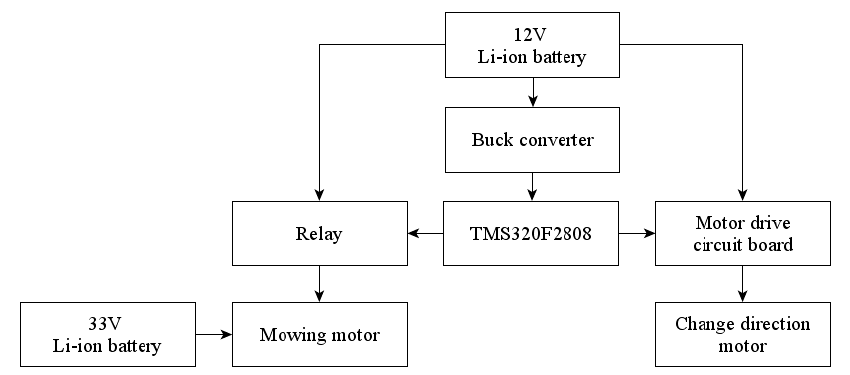
Figure 8. Mowing device power supply system.